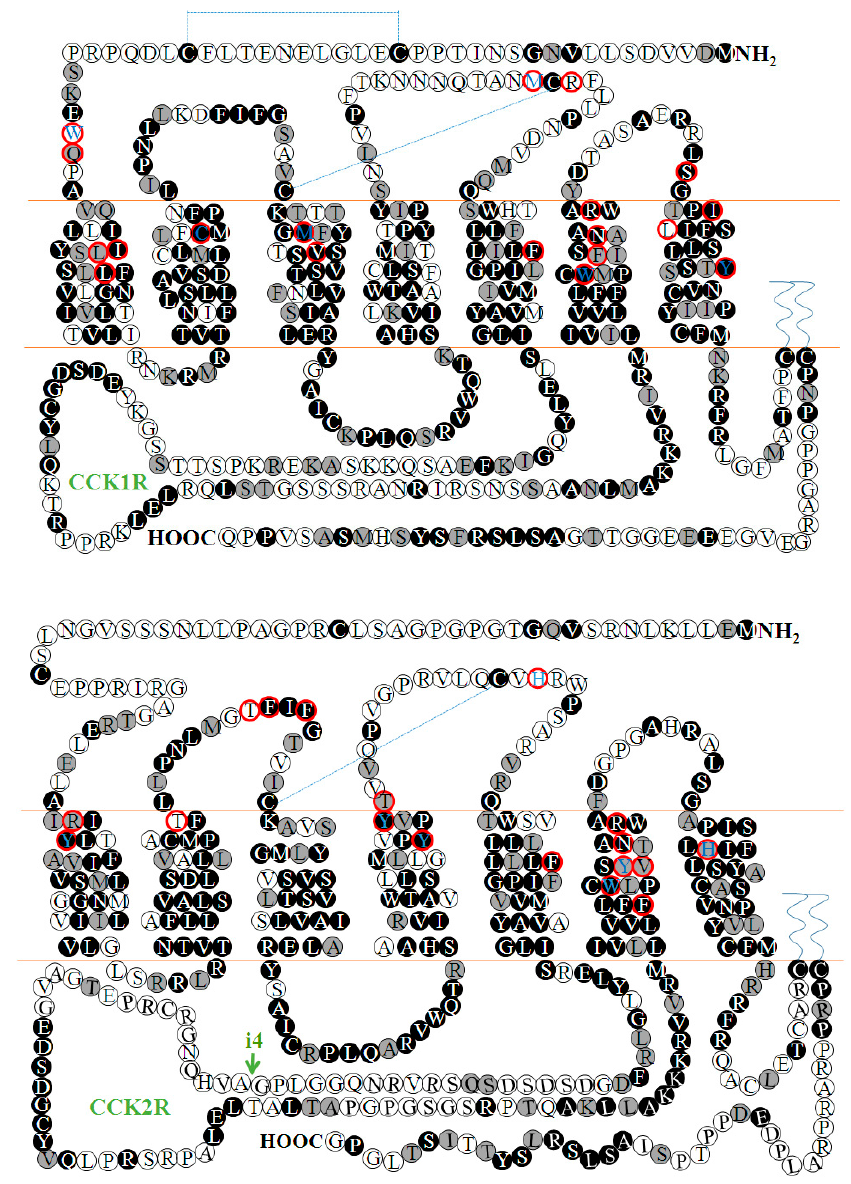
Figure A1. Plasma membrane topology of hCCK1R (upper panel) and hCCK2R (lower panel). Black circles filled with white letters indicate identical residues, gray circles indicate homologous residues. The dashed lines indicate disulfide bonds. Residues essential for agonist binding or CCK2R activation are in red boxes [69]. Blue letters indicate residues that play a key role in receptor activation and readily oxidized by 1 O 2 [70]. The green arrow in the lower panel indicates a site where a sequence of 69 residues is inserted due to a mis-spliced intron 4 [79].